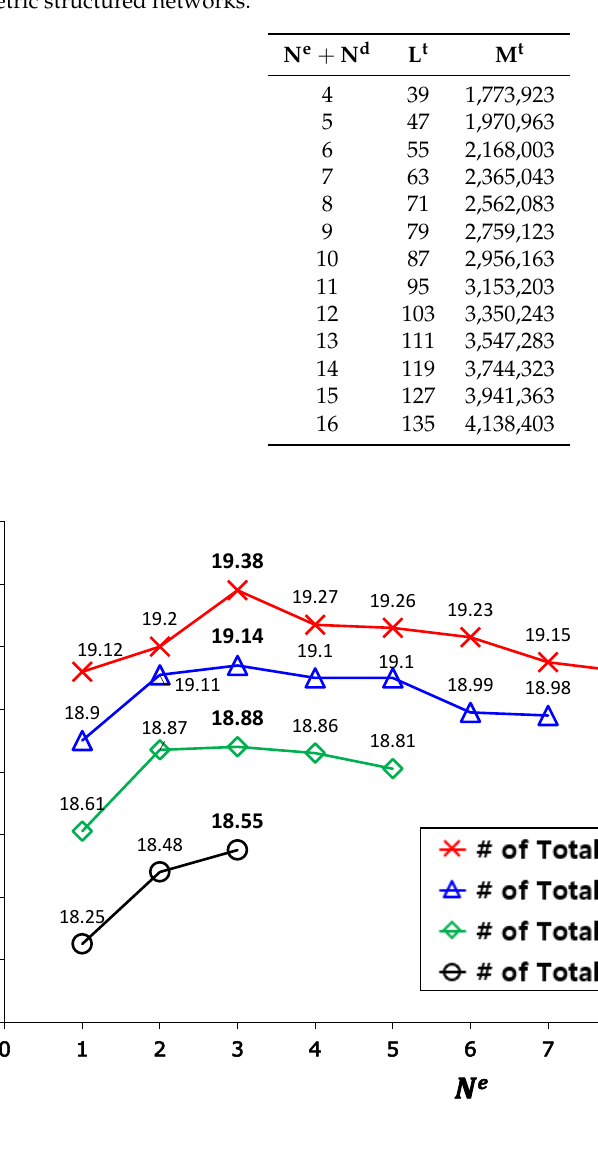
Figure 7. PSNR performance according to N e in a model with a fixed total number of